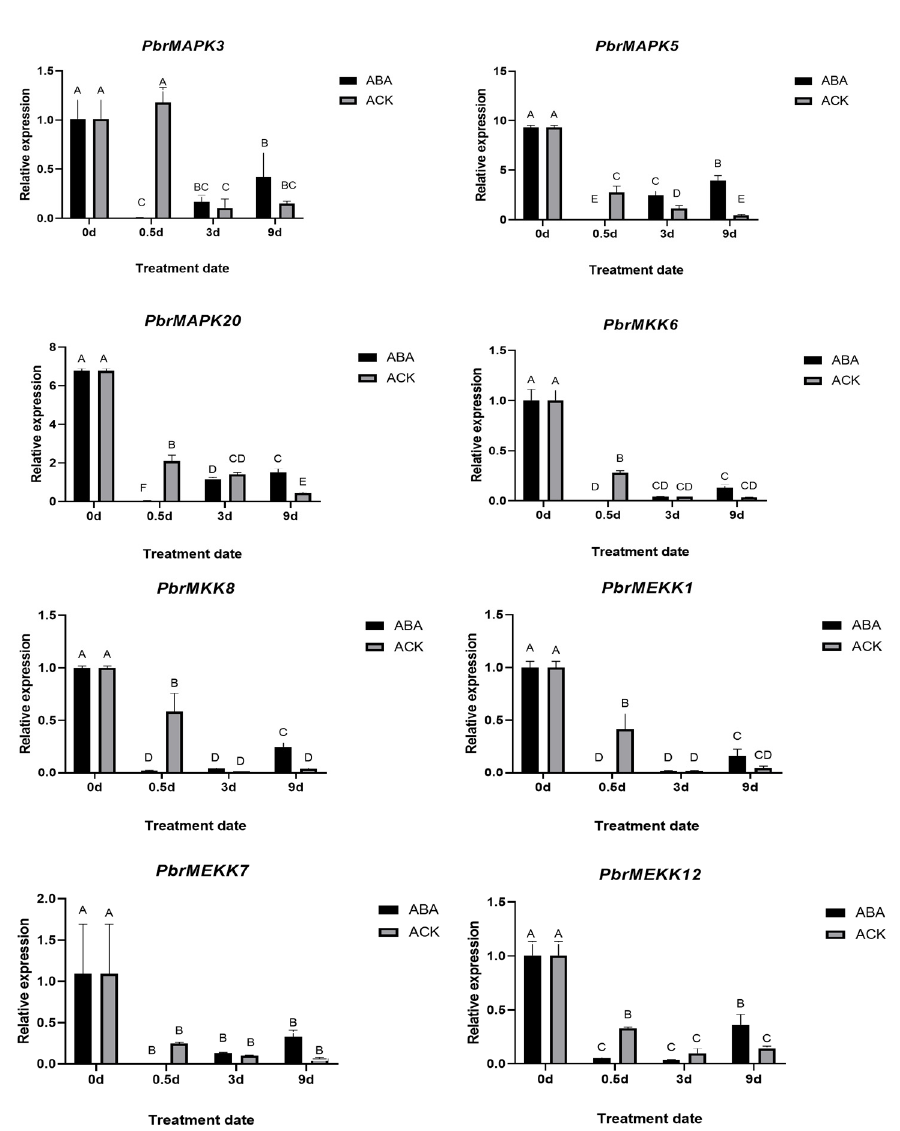
Figure 6. Differential expression for 8 MAPK cascade genes response to ABA treatment at 0 day, 0.5 day, 3 day, and 9 day, with water treatment as control. The above letter ABCDEF is the significant difference analysis result after graphPad analysis.